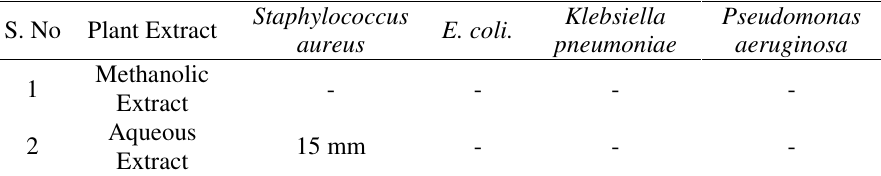
Table 1. Inhibition zones (in mm) in accordance to test microorganisms by agar disc